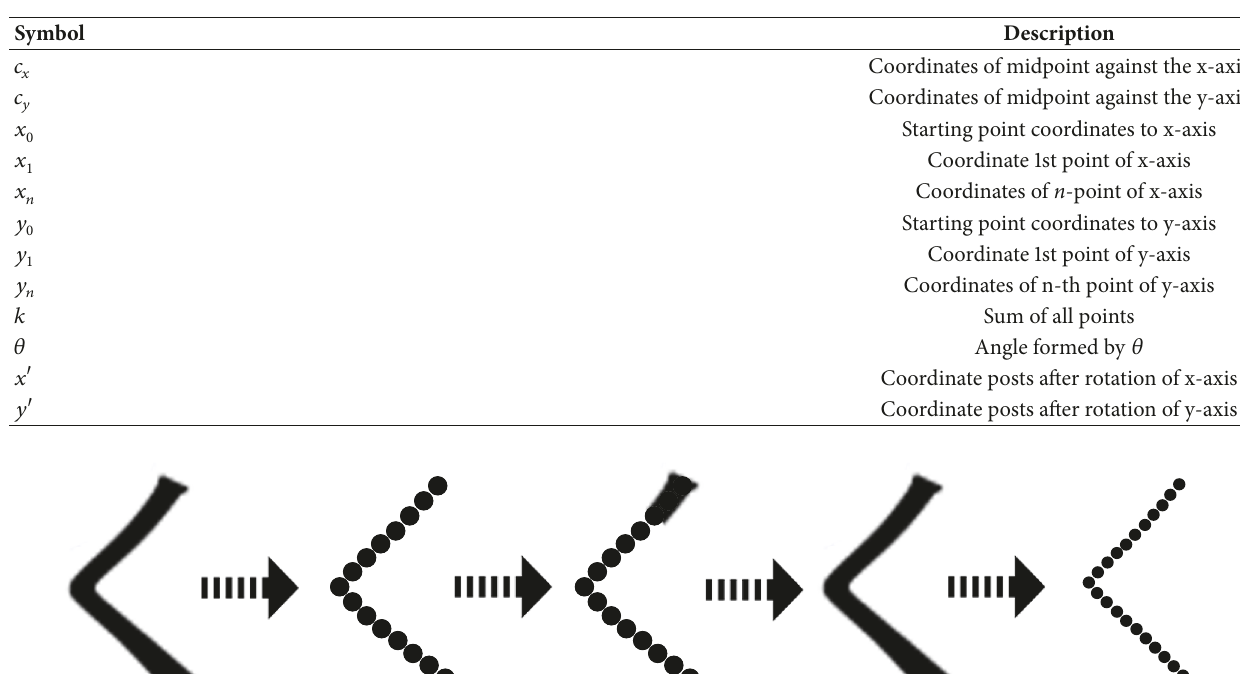
Figure 4: Resample Stages.